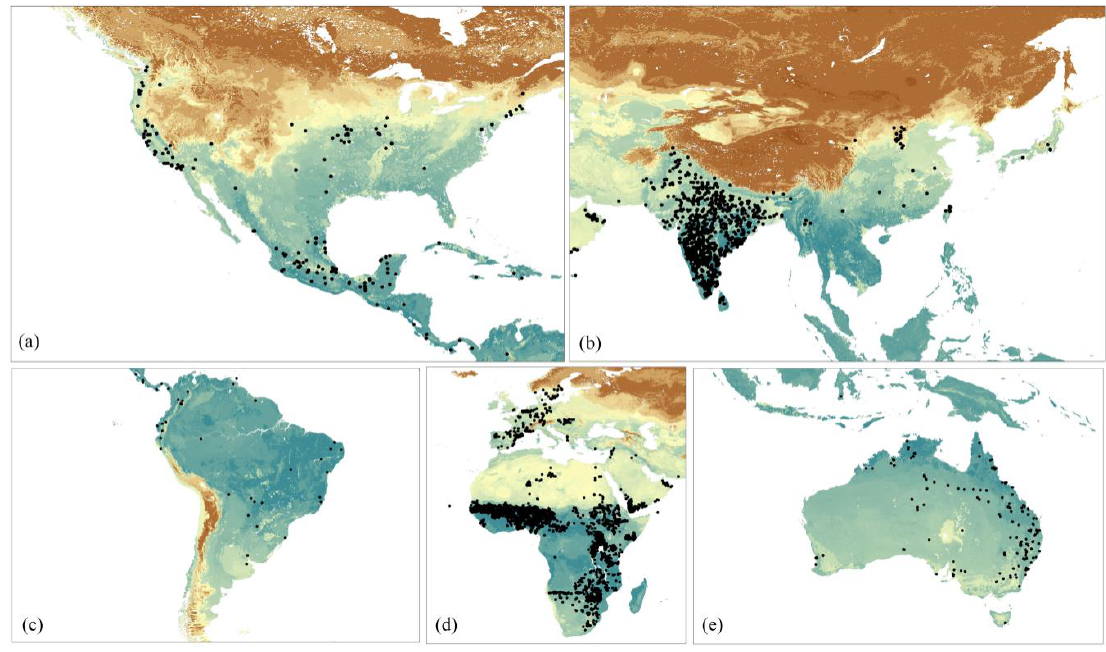
Figure 3. Spatial distribution of the validation samples with 1513 occurrence units: ( a ) North America; ( b ) Asia; ( c ) South America; ( d ) Africa and Europe; ( e ) Oceania. Table 2. Marginal lands suitable for sweet sorghum within each major world region and the top ten